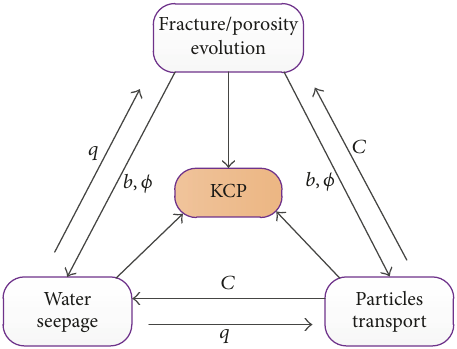
Figure 7: Coupling process among each